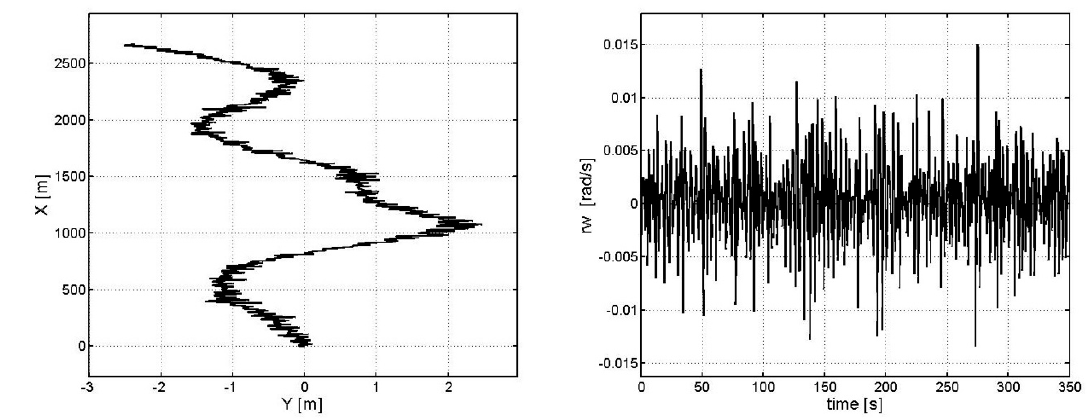
Figure 5. The trajectory of ship movement and signal of angular speed disturbance r w for sea state 5 and the wave angle 5 π /12.